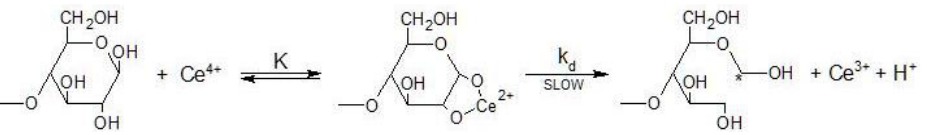
Figure 11. Possible mechanisms of Ceric ion initiation of starch. Adapted from [188].